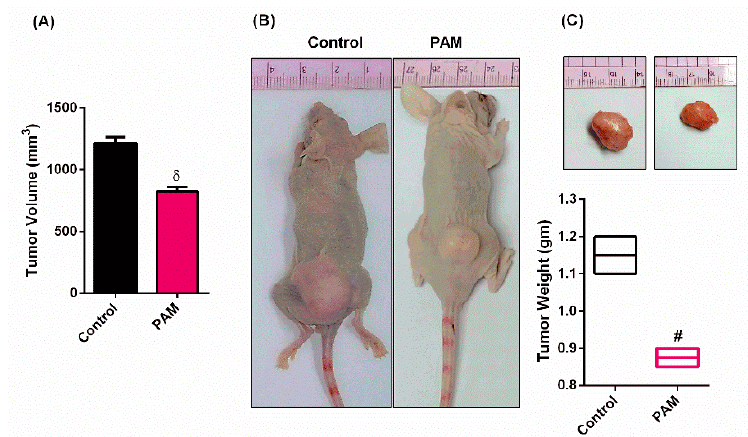
Figure 2. Anti-melanoma effect of PAM treatment in mice model. ( A ) Changes in the tumor volume of xenograft mice models. ( B ) Physiological observation of control and PAM treated nude mice bearing subcutaneous tumors on the right hind flank. ( C ) Photographs of solid melanoma excised from control and treatment mice on the 21st day of the study are shown above the respective bar graphs. Bar graph shows the mean tumor weight of the excised control and PAM treated melanoma. Data are mean ± SD of the mean, n = 3. * p < 0.05; δ p < 0.01, # p < 0.001.